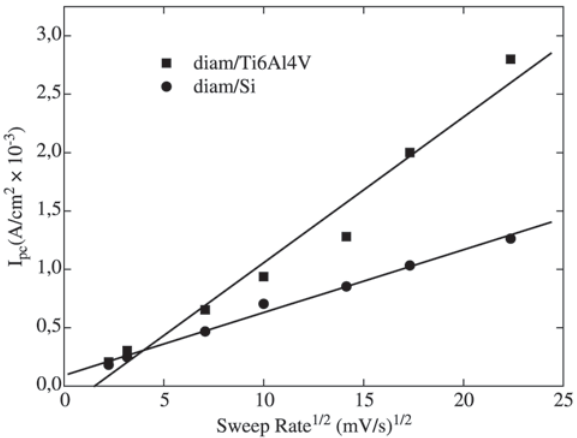
Figure 6. Cathodic peak current as a function of (sweep rate) 1/2 in